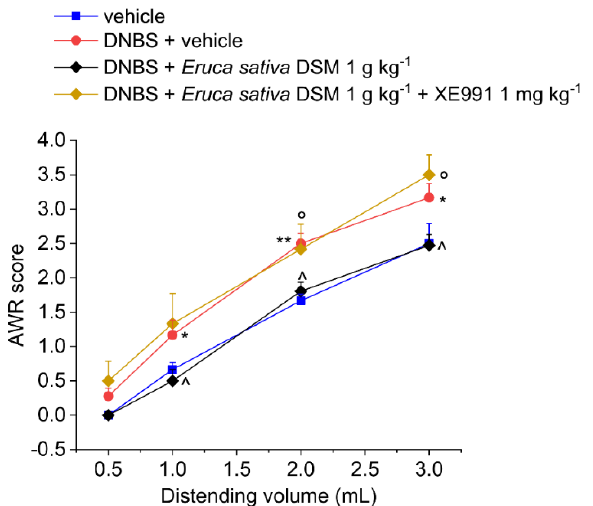
Figure 3. Involvement of the Kv7 potassium channels in the acute pain-relieving effect of Eruca sativa DSM. Visceral sensitivity was assessed in animals by measuring the extent of the abdominal withdrawal response (AWR) to colorectal distension, carried out by applying an increasing distending stimulus on the colon walls (0.5–3 mL). The Kv7 potassium channel blocker, XE991 (1 mg kg − 1 ) was intraperitoneally administered in concomitance with Eruca sativa DSM (1 g kg − 1 ), and the test was performed after 30 min. Each value represents the mean ± SEM of six animals per group. * p < 0.05 and ** p < 0.01 vs. vehicle. ^ p < 0.05 vs. DNBS + vehicle. ° p < 0.05 vs. DNBS + Eruca sativa DSM.